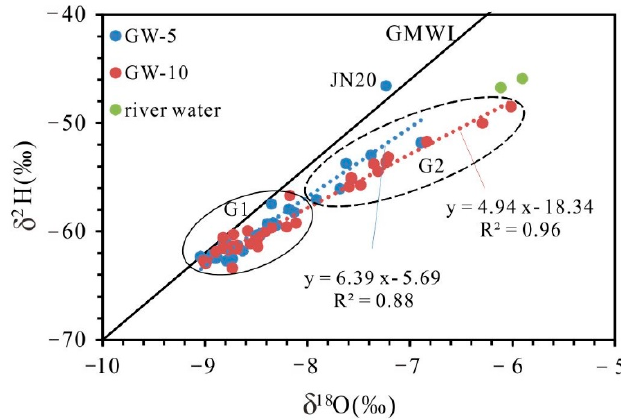
Figure 5. Plot δ 18 O versus δ 2 H for river water and karst groundwater in the study area (GMWL = global meteoric water line; LMWL = local meteoric water line).